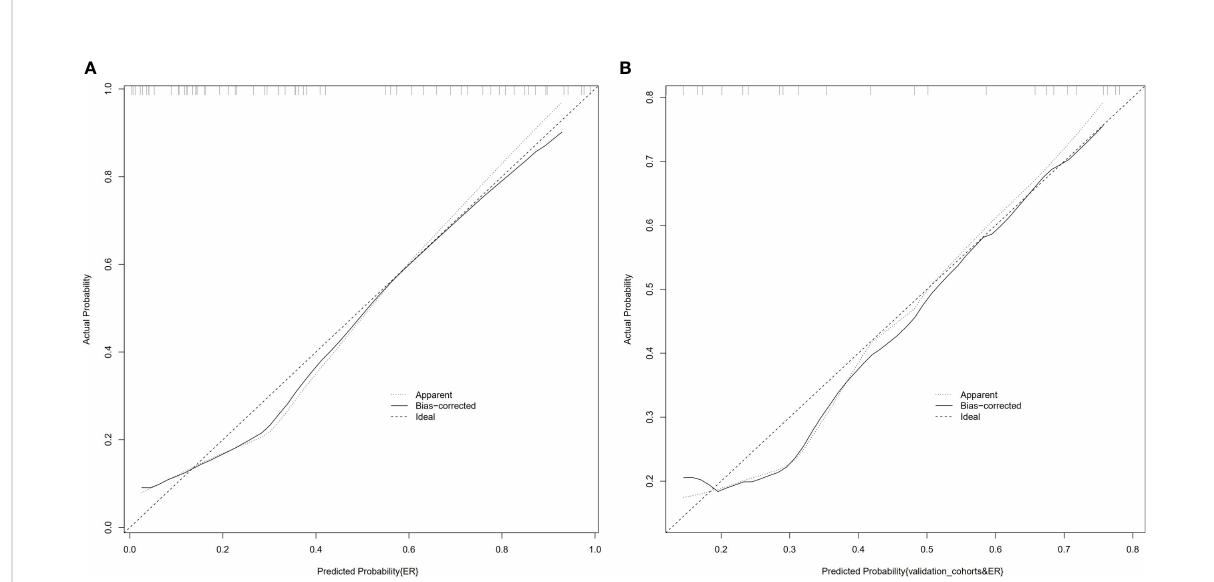
FIGURE 5 Calibration curves of the combined nomogram in the training cohort (A) and the validation cohort (B) . The vertical axis displays the actual results. The horizontal axis represents the probability of prediction. The slash dotted line represents the reference line and represents the “ ideal ” prediction. The solid line represents the performance of the nomogram. If the solid line is closer to the diagonal dashed line, it means that the prediction is better.